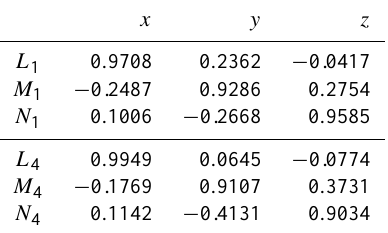
Table 2. LMN basis for Cluster 1 ( L 1 M 1 N 1 ) and Cluster 4 ( L 4 M 4 N 4 ) in GSE